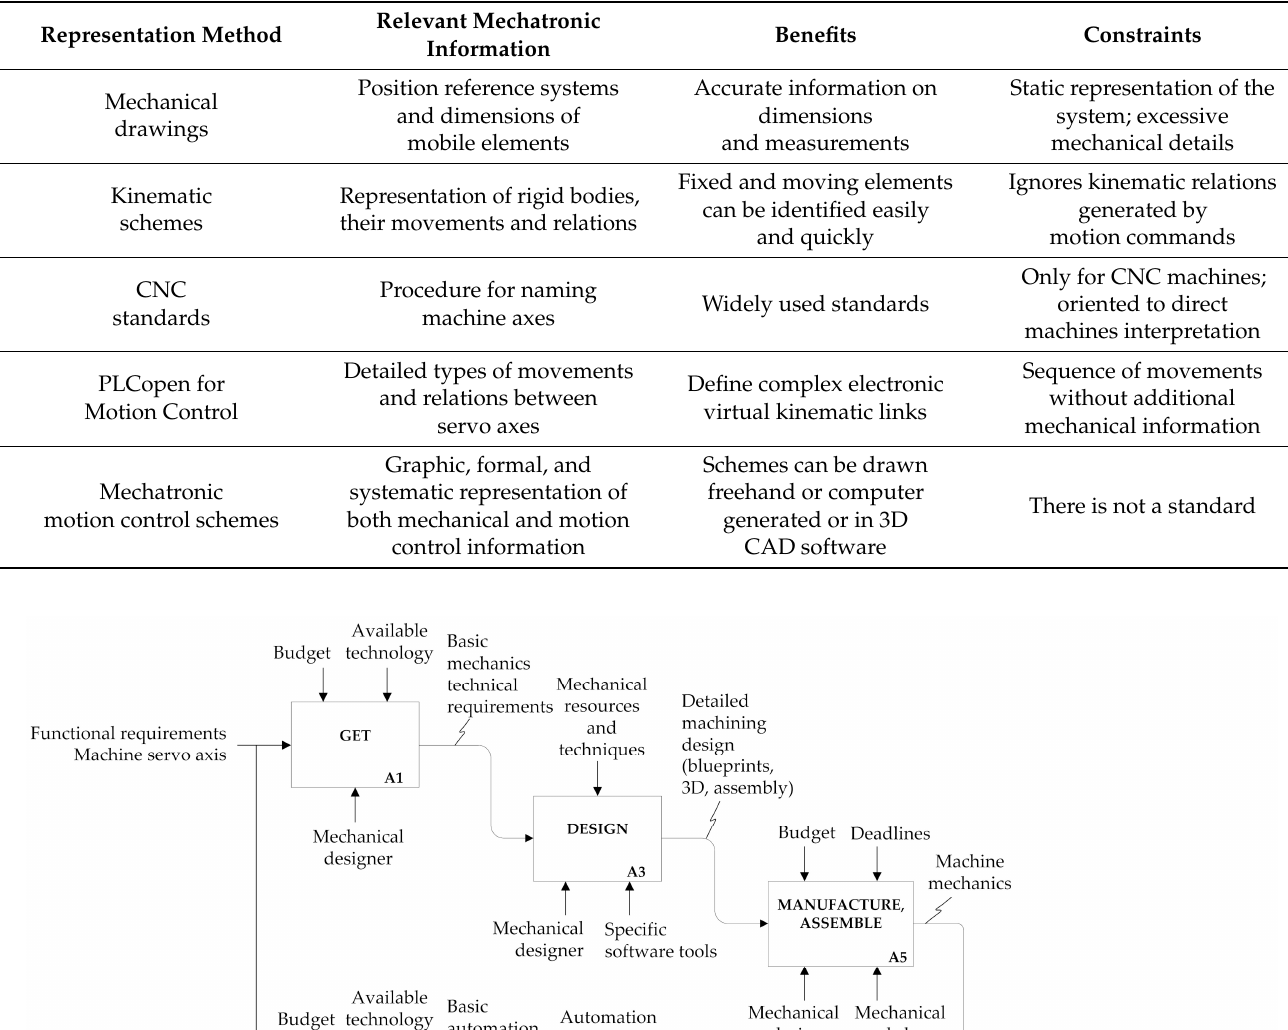
Table 1. Comparison of standard representation systems and the proposed joint representation.